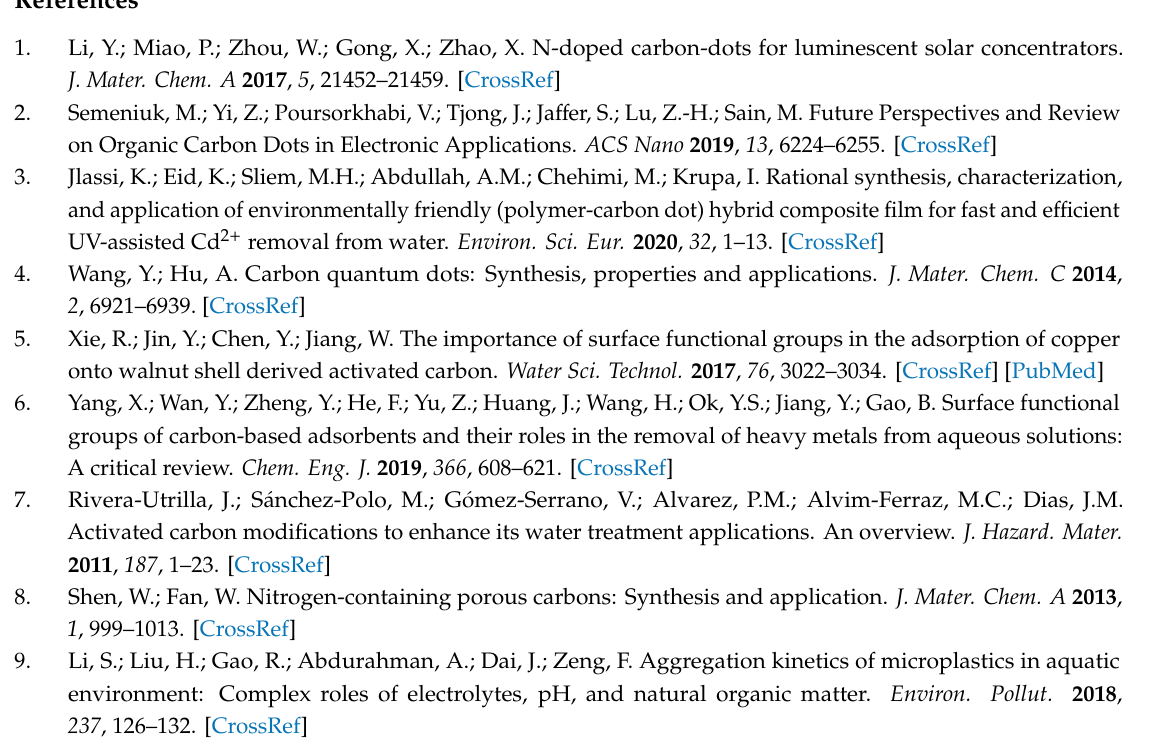
Supplementary Materials: The following are available online, Figure S1: DLVO energy between N-CDs under di ff erent solution conditions, Figure S2: DLVO energy between N-CDs and quartz surfaces under di ff erent solution conditions, Figure S3: DLVO energy between N-CDs / CDs and quartz surfaces (pH 6), Table S1: The maximum energy barrier ( Φ max) and Secondary minimum ( Φ min2) calculated by DLVO